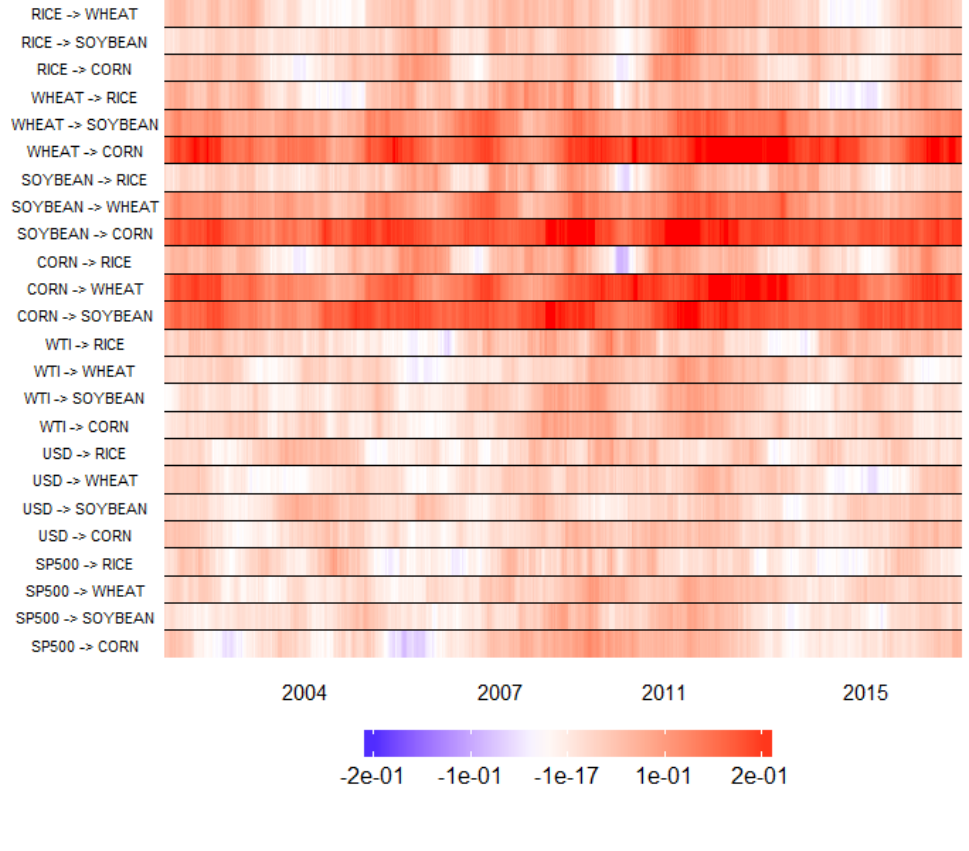
Figure 9: Responses of the food markets to shocks originating from other markets (the lasso